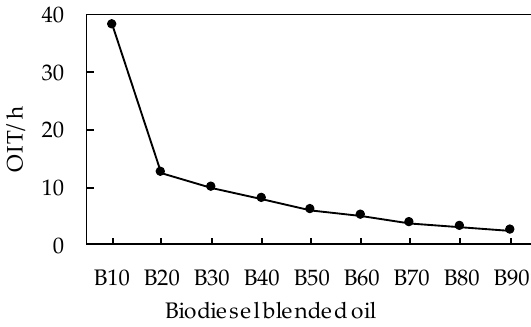
Figure 6. Effects of blending ratio of biodiesel on OIT (oxidation induction time).